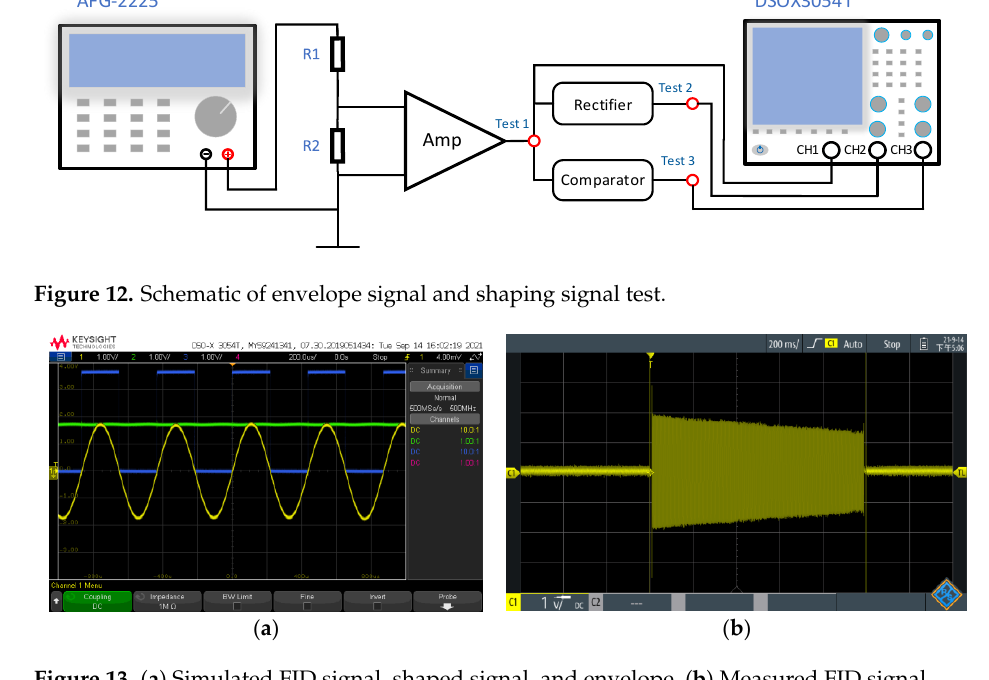
Figure 14. Digital circuit block diagram.